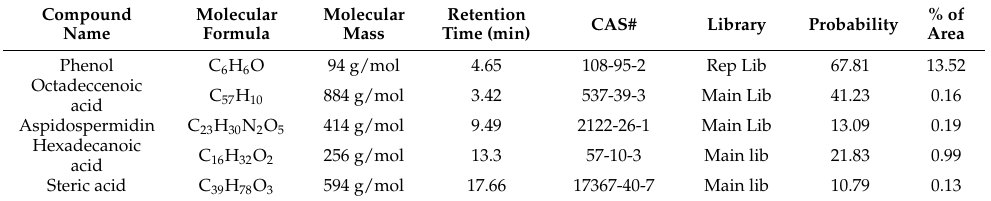
Table 6. Major constituents of bacterial extract of H2 (A6S7) were identified by GC–MS analysis.